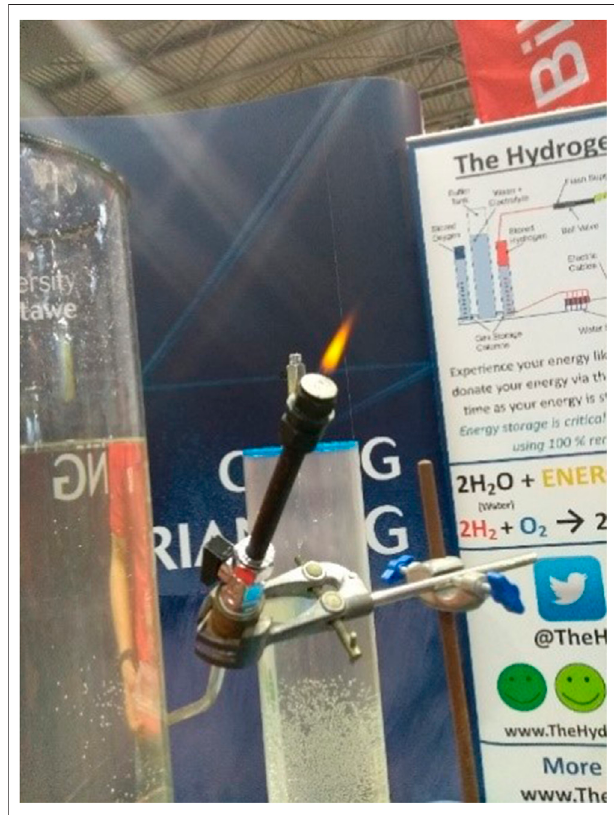
FIGURE 4 | Image of the stable hydrogen fl ame presented as the climax of the demonstration.